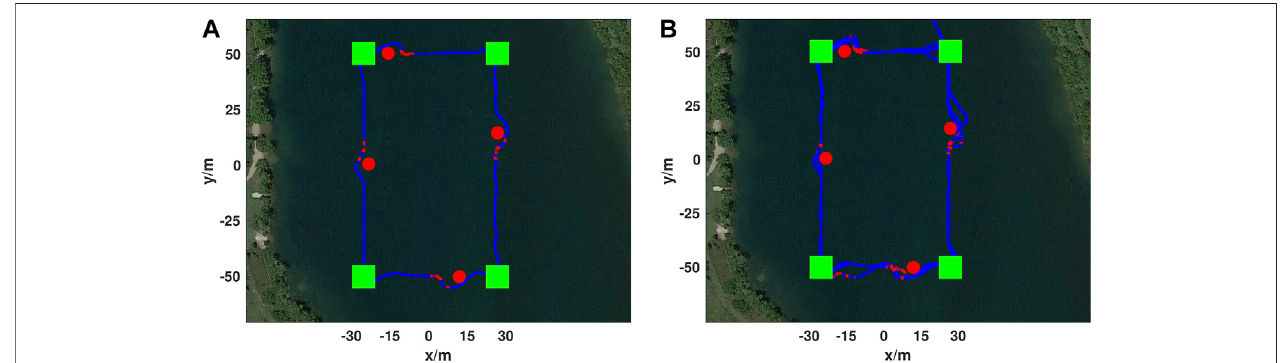
FIGURE9| Real-worldASVobstacleavoidancetest.Missionwaypointsasshownasgreensquares,placedobstaclesasredcircles,DRLagentaugmentedpaths in red, and the vehicle trajectory following the mission path in blue. An example trajectory from the test is shown (A) and took 252 s and covered 320 m. In total this missionranfor19 minwithoutcollision (B) andonly stopped duetoahumancommandtostopactuation. Theaugmented path shownclosetothebottomleftwaypoint ( − 30, − 50) was caused by a passing boat. The mission trajectory starts at (20, 70) and fi rst goes to the top right mission waypoint (30, 50) and progresses counter-clockwise.